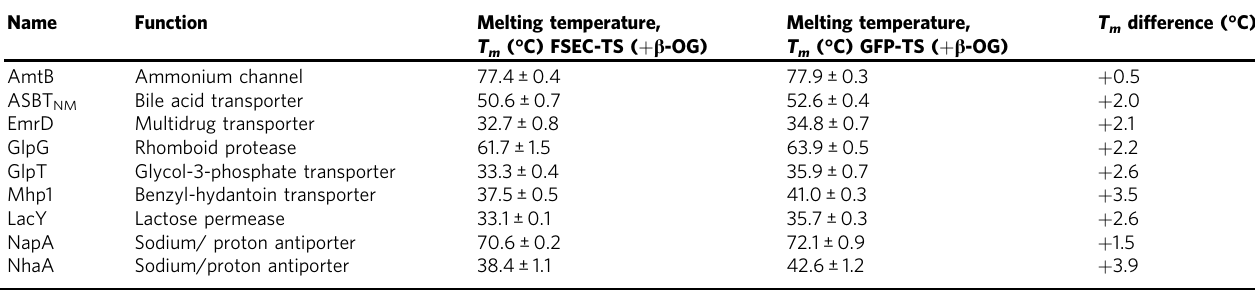
Table 1 Membrane bilayers are made up of a myriad of different lipids that affect membrane proteins, but identifying those speci fi c lipid requirements remains a challenge. Here, authors present an engineered thermal-shift screen which reveals speci fi c lipid preferences of eukaryotic and prokaryotic membrane